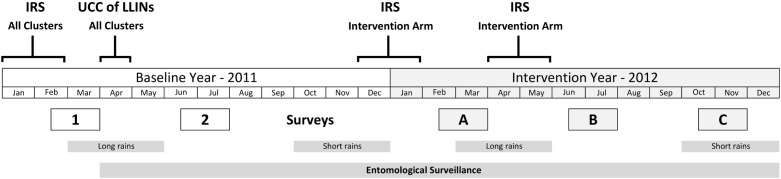
Study timetable.Note: Surveys 1 and 2 are baseline surveys. Surveys A, B and C are post intervention.